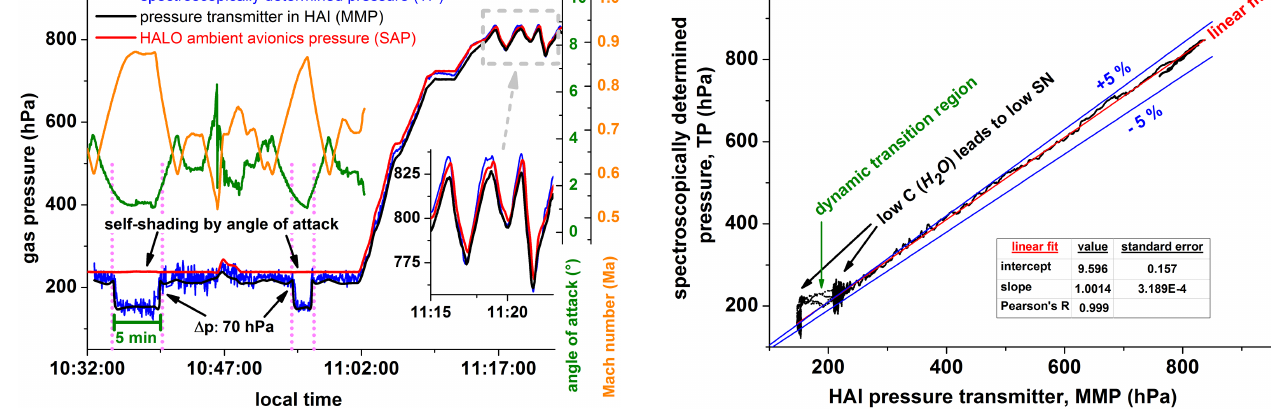
Figure 10. Correlation plot between HAI’s micro-mechanical pres- sure transmitter (MMP) and the spectroscopic TDLAS pressure measurement (TP). Overall, the correlation can be well represented with a linear fit (red line) with a slope of 1.0014 and R = 0 . 9992. The complex flow dynamic effects (e.g. Fig. 8) have some influence on the correlation, particularly at lower pressure, and can lead to self-shading effects (marked green; see Fig. 9) in the dynamic tran- sition region. The higher noise level at low pressures results from the strong H 2 O decrease at higher flight